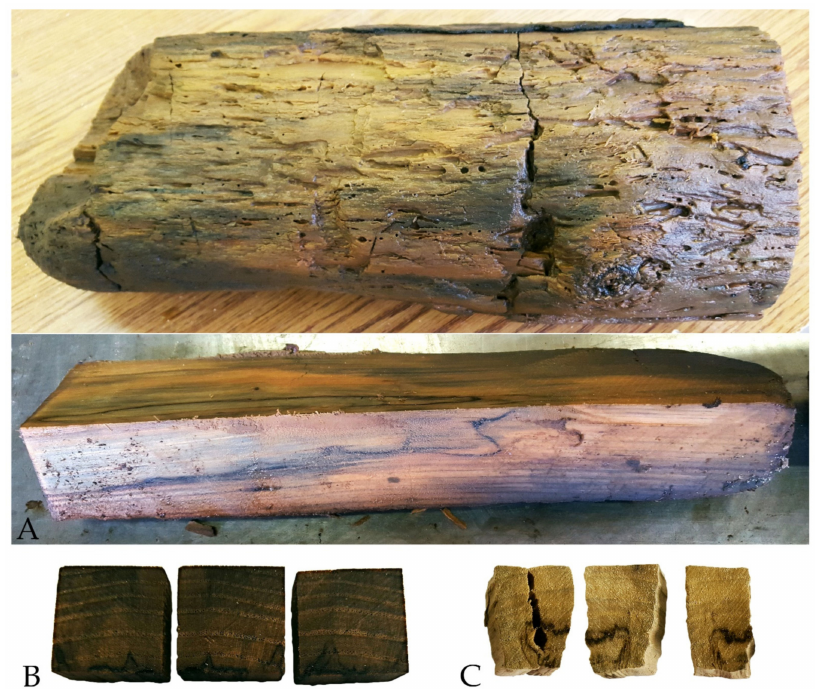
Figure 3. Highly degraded waterlogged elm wood excavated from the Lednica Lake, the Wielkopol- ska region, Poland (the loss of wood substance was about 70–80% with highly reduced cellulose and hemicelluloses content [42]); ( A ) part of a log shortly after excavation (upper photo) and cutting (lower photo); ( B ) untreated waterlogged elm samples (completely filled with water); ( C ) untreated samples shrunken upon air-drying.